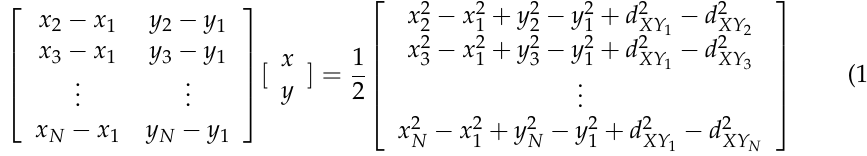
d XY (calculated by n